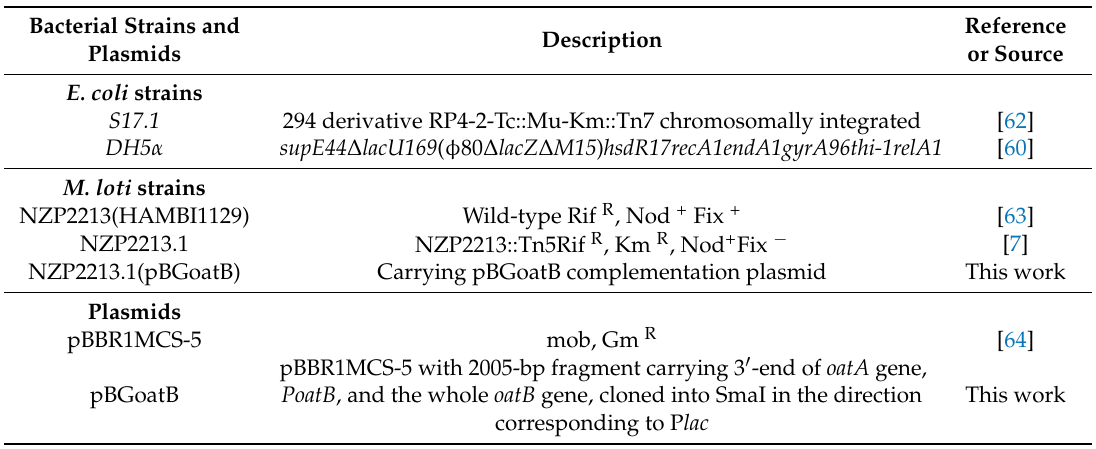
Table 2. Bacterial strains and plasmids used in this